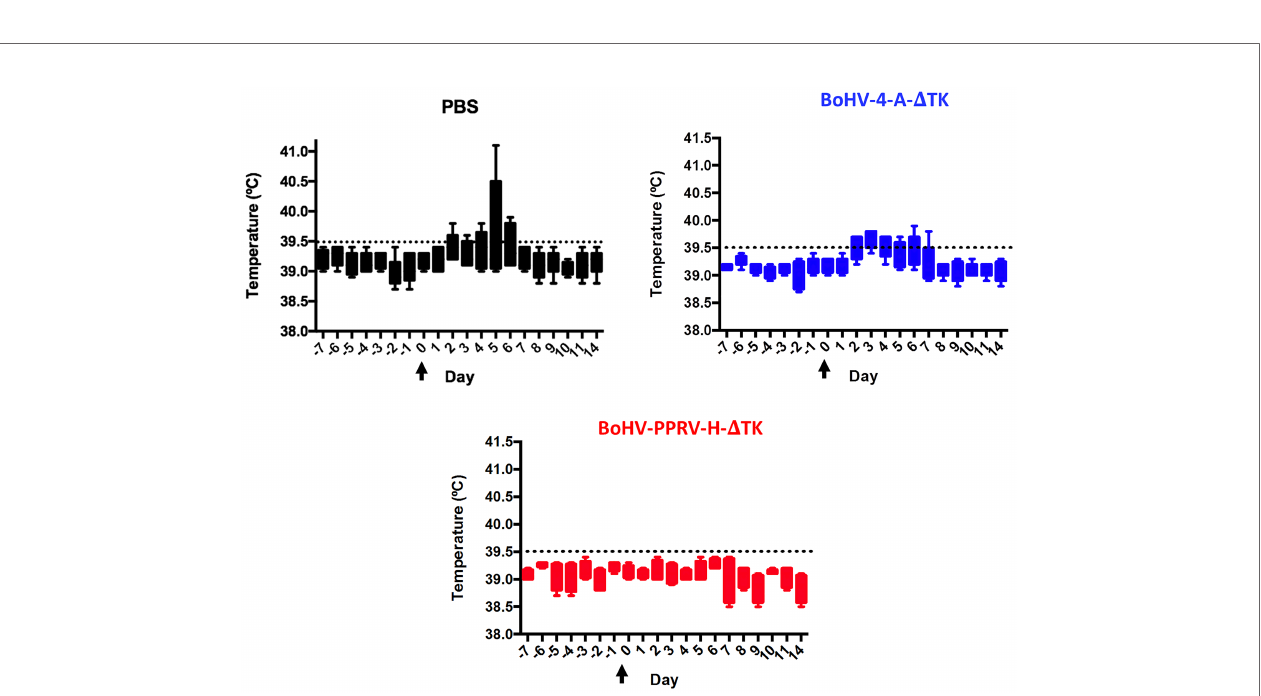
FIGURE 2 | Rectal temperature in immunized sheep. The temperatures from day 38 (day − 7) of the experiment to day 14 PC are represented in a box and whiskers plot that shows the minimum to maximum values in a box. As indicated, each panel corresponds to each experimental group of animals. Arrows indicate the day of ICV ’ 89 PPRV challenge (day 0). The threshold temperature value above which animals were considered to have fever (39.5°C) is indicated as a dashed line in each